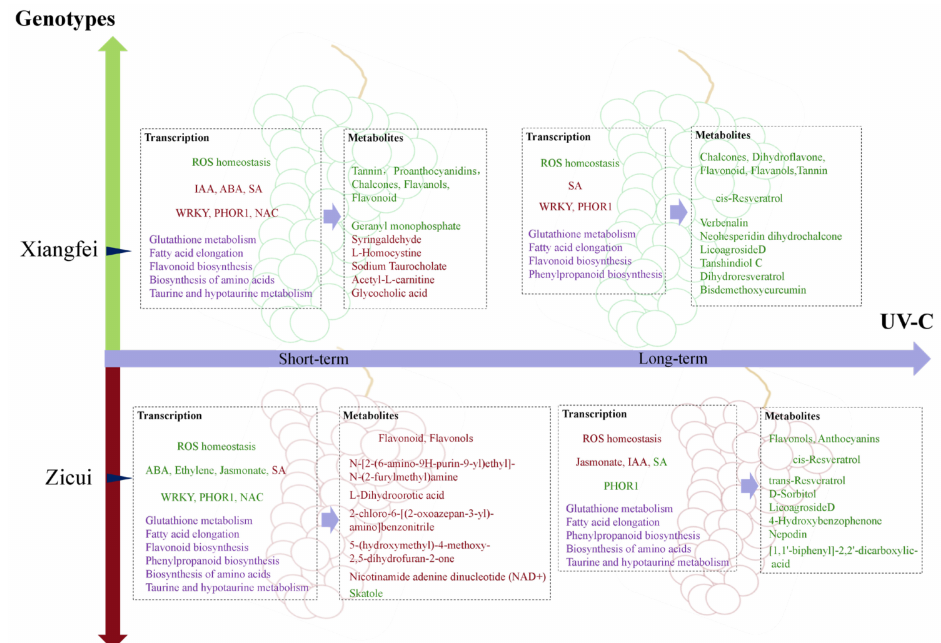
Figure 10. A summary of post-harvest UV-C application regulating the quality development of grape berries. The gene transcription part mainly included ROS homeostasis, hormone synthesis path- way, transcriptional regulatory factors, and quality component-related metabolism. Hormones and transcriptional regulators with obvious changing patterns and the differential metabolic pathways commonly present in the two cultivars after UV-C treatment were all listed in the summary. In the metabolites section, flavonoids and other differential metabolites (the top three most significant metabolites in the pos and neg modes according to the p -value) were listed. Green represents the up- regulated transcription or accumulation level, while red represents the downregulated transcription or accumulation level. Purple represents a significant difference compared to the